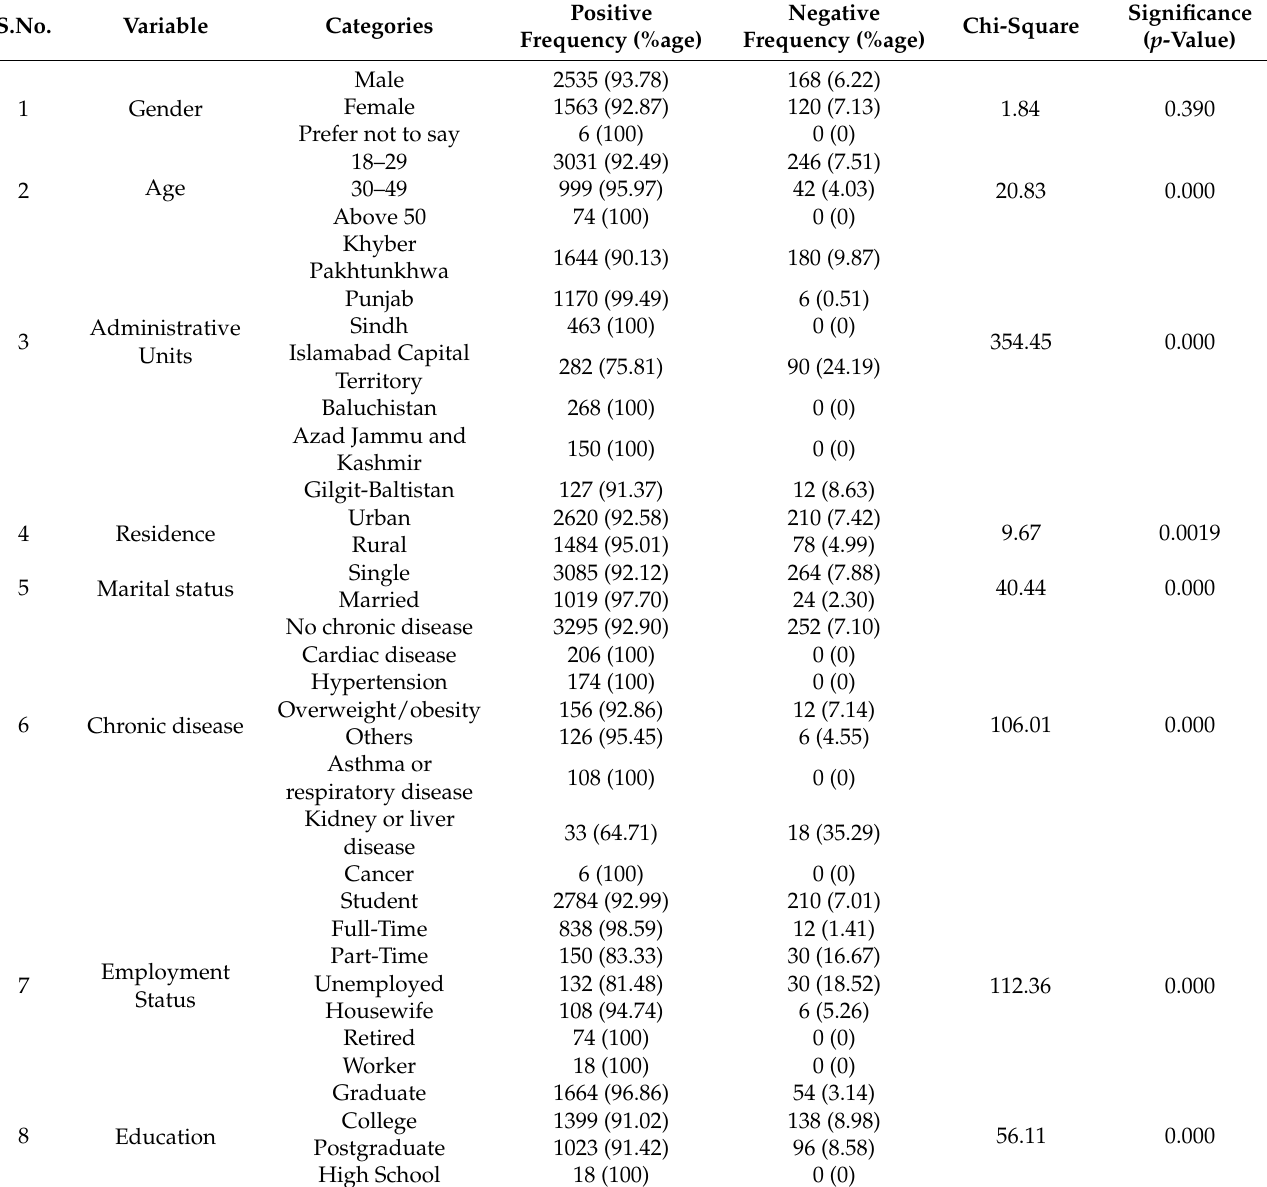
Table 5. Association between intentions and demographic variables ( n =